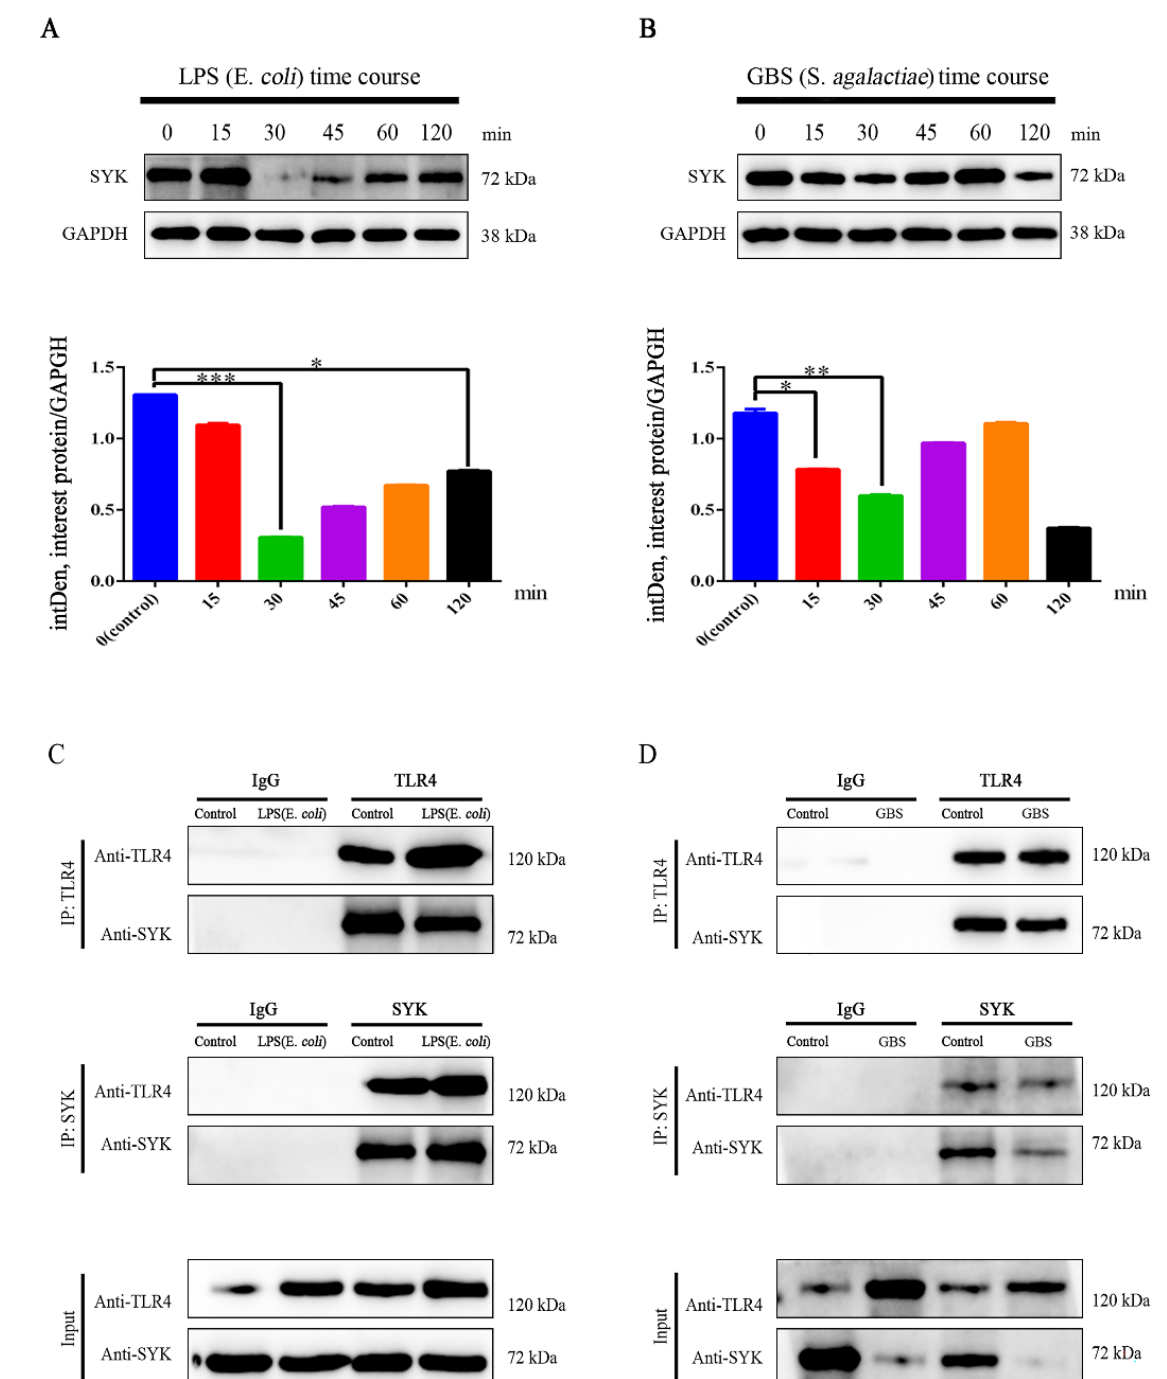
Figure 5. SYK levels, correlation between TLR4 and SYK in bMECs with LPS or GBS 30 min. ( A , B ) SYK protein levels in bMECs with LPS ( E. coli , 25 μg /mL) stimulation or GBS (MOI = 10) infection (time course); ( C ) coimmunoprecipitation of TLR4 and SYK in bMECs with LPS (Up: TLR4 pulled SYK; Middle: SYK pulled TLR4; Down: input); ( D ) coimmunoprecipitation of TLR4 and SYK in bMECs with GBS (Up: TLR4 pulled SYK; Middle: SYK pulled TLR4; Down: input). * p < 0.05, ** p < 0.01, *** p < 0.001.